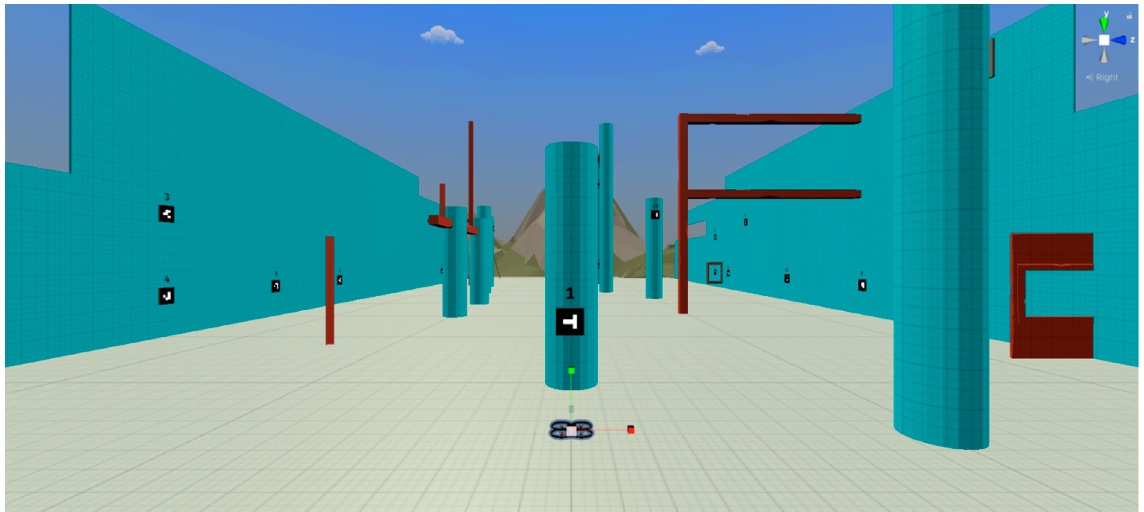
Figure 15. Results from Test 2, performed to measure the timings corresponding to how long a user takes to react after the detection of a marker and representation of the respective 3D model.